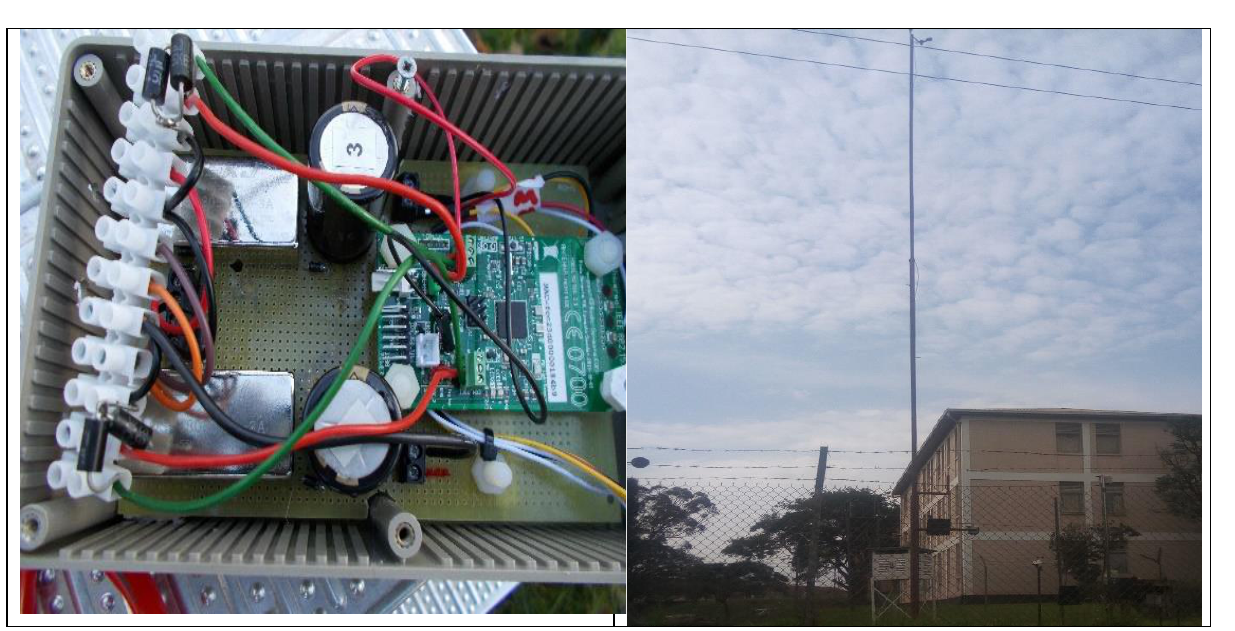
Figure 6 . Left: Contents of a sensor node; Right: Deployment site for the AWS, showing the 10m stand on which three sensor nodes (2m, 10m and gnd) are placed. The gateway is placed in the building, close to the window on second floor, approximately 80 feet from the AWS